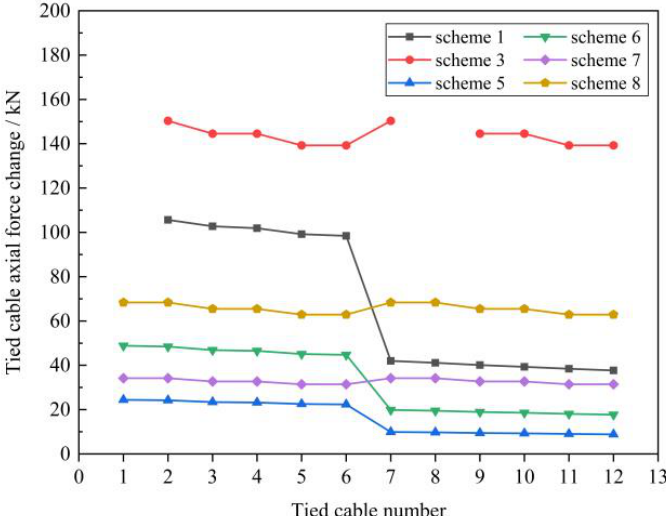
Figure 10. The cable force change in the adjacent tie cables.